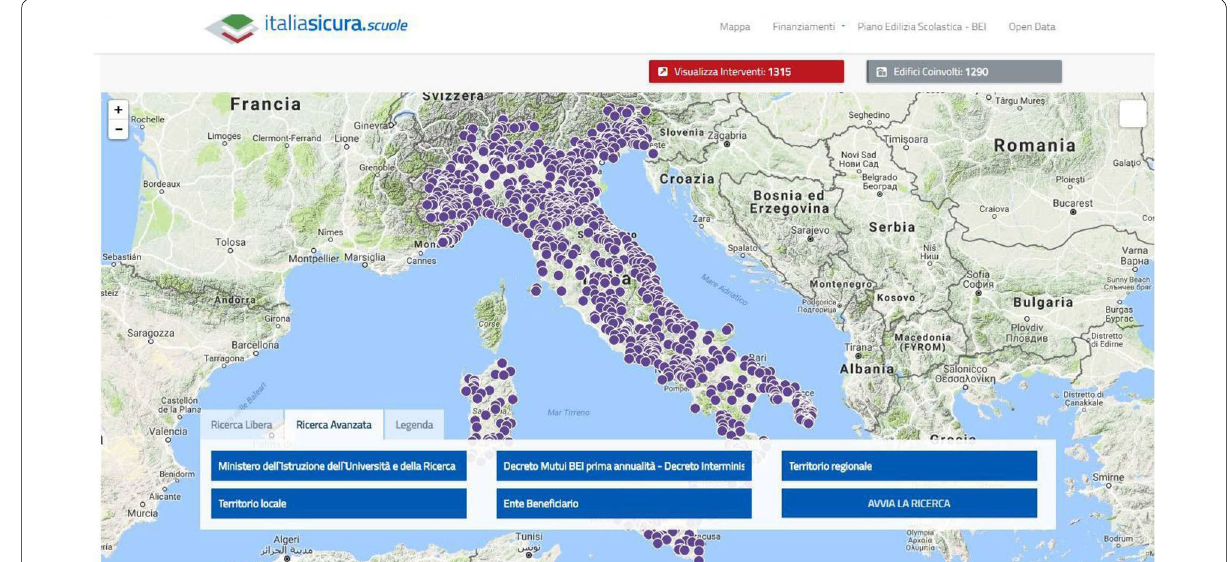
Fig. 2 ItaliaSicura Scuole, Schools with funding source or single administration, regional or local. (Source: Governo. ItaliaSicura Scuole. http://www. canti erisc uole.it Accessed 10 January 2018, the site has not been updated since the SMES closure, since January 2019 no longer available